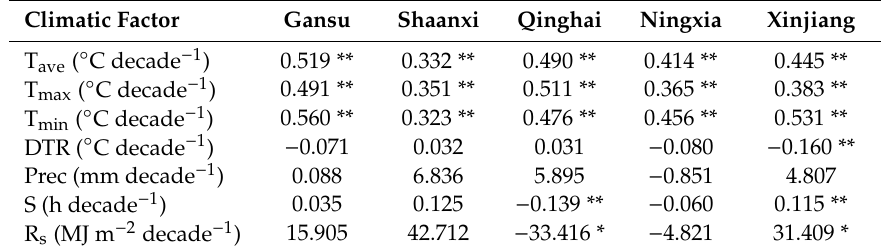
Table 2. Trends in climate variables during the potato growing season from the period 1982 to 2015 in different provinces of northwest China.